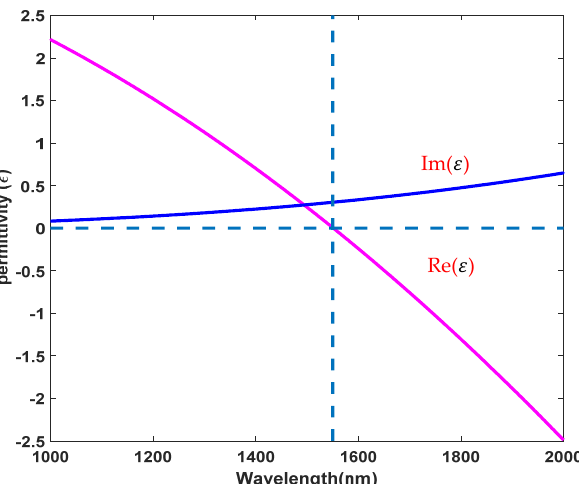
Figure 2. Calculated real and imaginary parts of the permittivity of the ITO film as a function of wavelength.